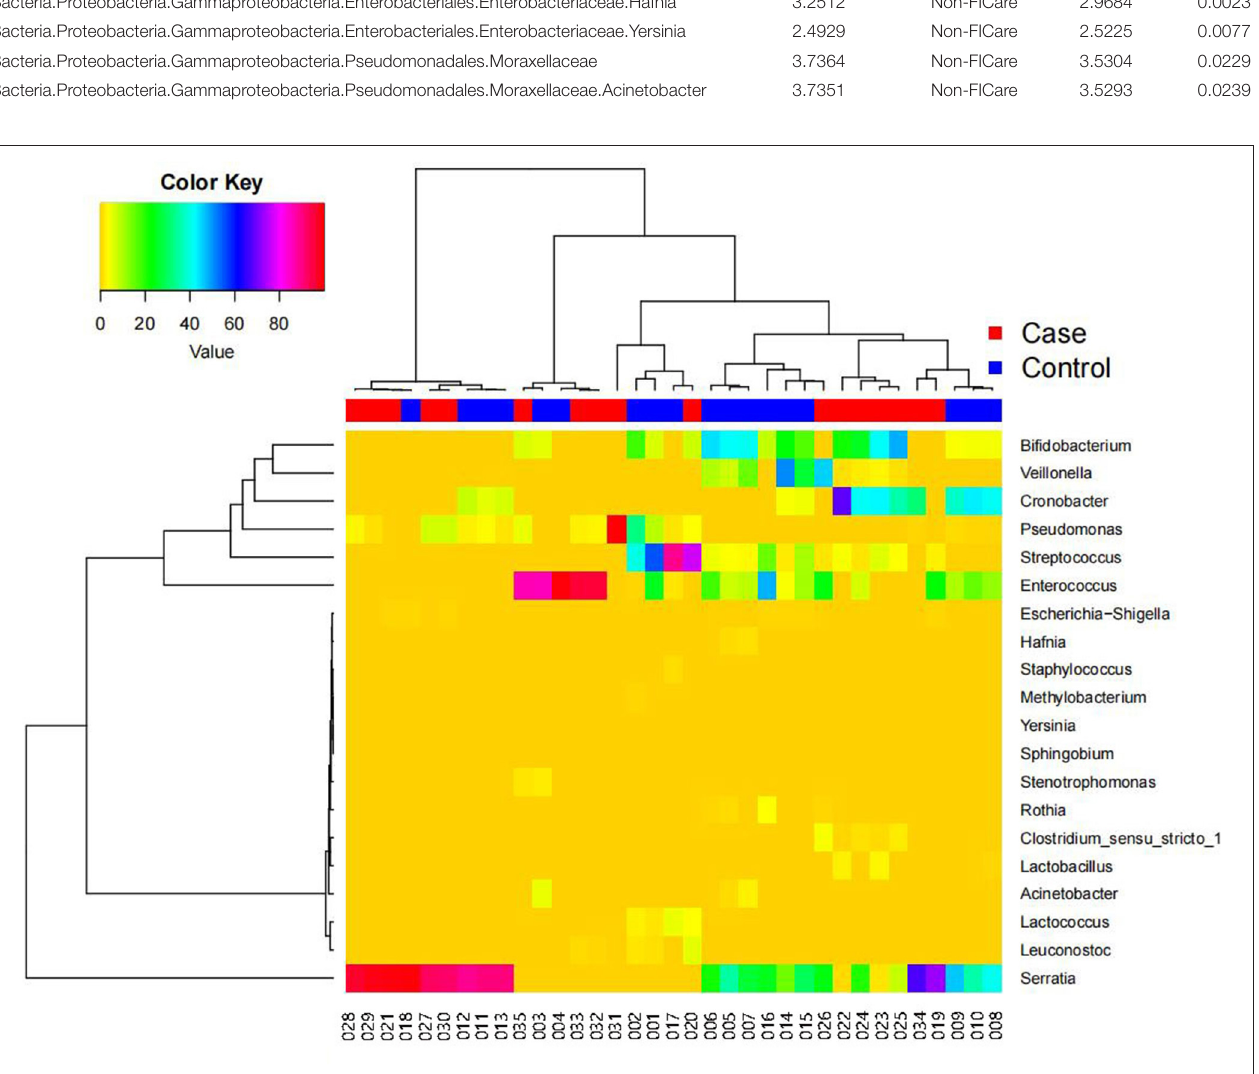
Shannon index and Simpson index reflect the diversity of microorganisms in each sample, which is affected by species richness and evenness. The Shannon index is more sensitive to the richness of the community and the rare OTU, and is more suitable for complex communities; while the Simpson index is more sensitive to the uniformity and the dominant OTU in the community, and is more suitable for simple communities.